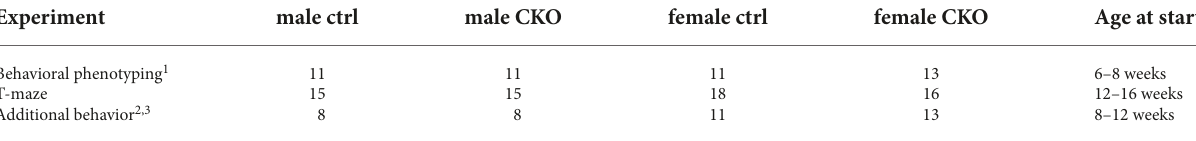
TABLE 1 Cohorts of mice used for experiments. Experiment